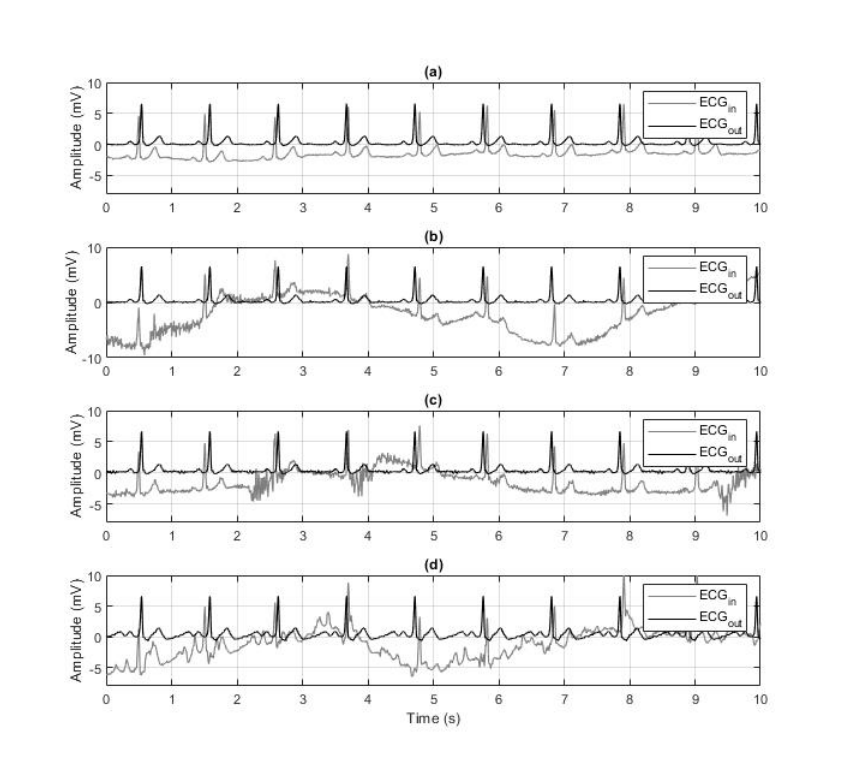
Figure 5. As an example, the figure depicts an ECG window from recording number 202 at the input ( ECG in ) and at the output of the extended segmented beat modulation method (ESBMM). In panel ( a ), ECG in was not corrupted by additional noise. Differently, in panels ( b – d ), ECG in was corrupted by baseline wander, muscle activity, and electrode motion artifacts,